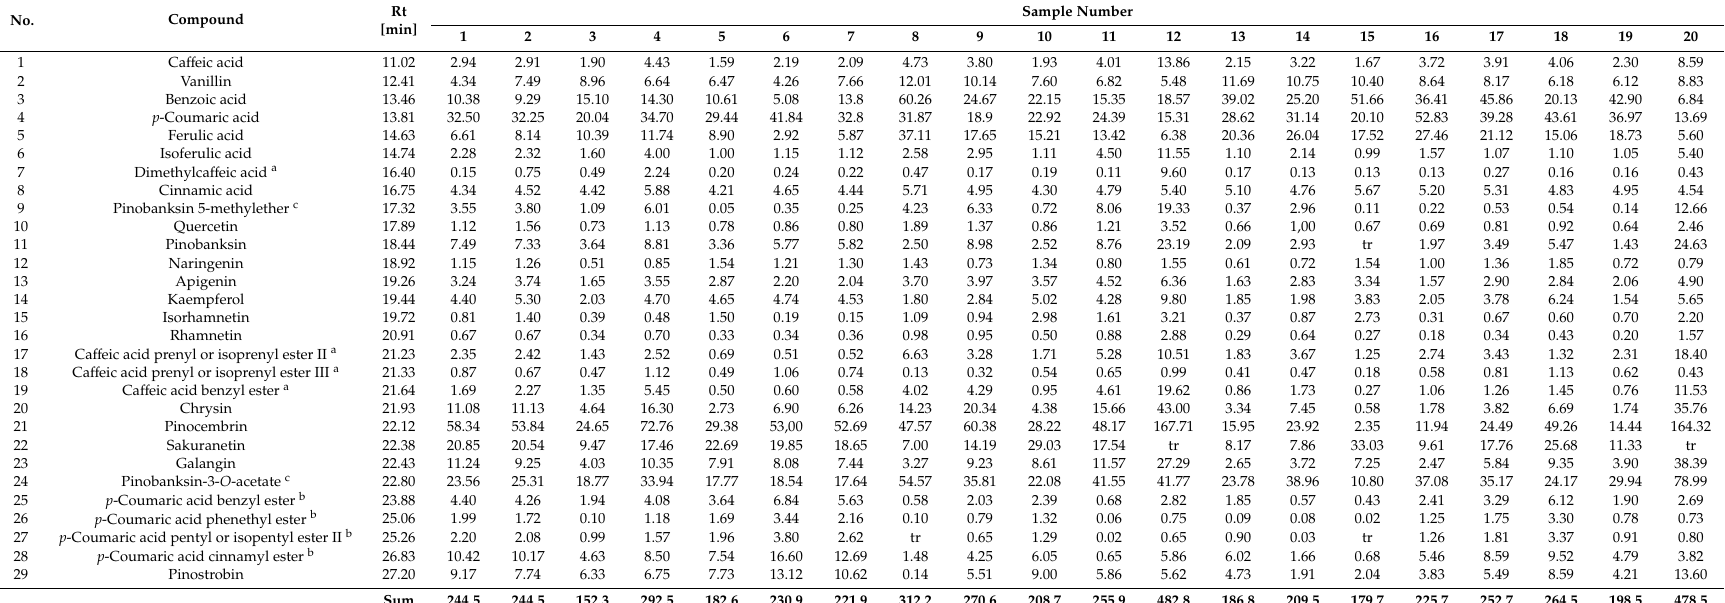
Table 6. The content of selected major compounds determined in propolis extracts by UHPLC-DAD (data are expressed as mg / g of extracts).